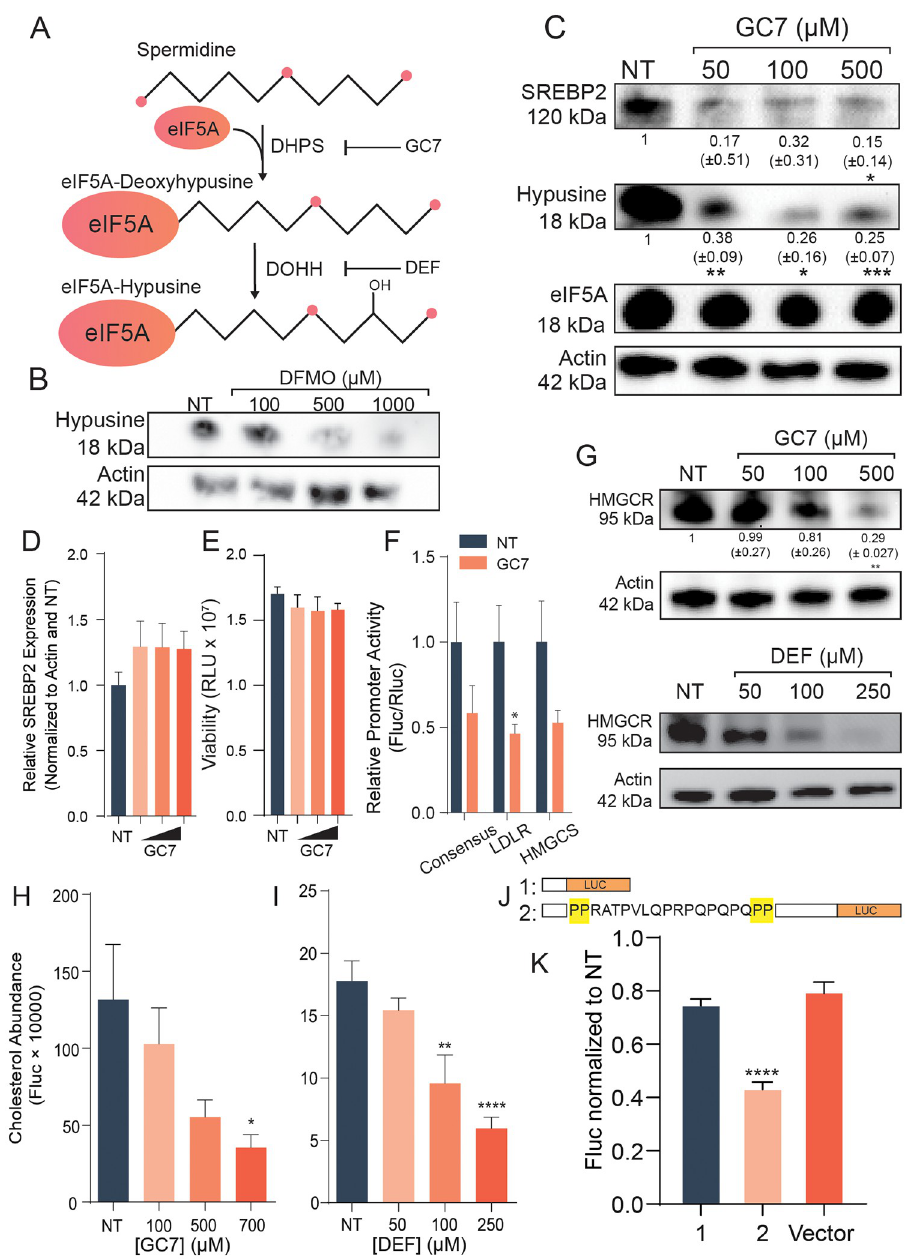
Fig 5. Hypusination supports cholesterol synthesis. (A) Pathway of eIF5A hypusination and its inhibition. (B) Huh7 cells were treated with increasing doses of DFMO and analyzed by western blot for hypusinated eIF5A. (C) Western blot of Huh7 cells treated with increasing doses of GC7 probed for SREBP2, hypusine-eIF5A, and total eIF5A. (D) Huh7 cells were treated with increasing doses of GC7 and SREBP2 transcription measured by qRT-PCR. (E) Cells were treated as in (D) and analyzed for viability after 24h of treatment. (F) Huh7 cells treated with 500 μ M GC7 for 24h followed by transfection with the SRE promoter luciferase constructs and renilla luciferase as a transfection control. Results were normalized to untreated conditions, relative to renilla luciferase activity. Two-way ANOVA was used to analyze statistical significance. (G) Western blot of Huh7 cells treated with increasing doses of GC7 or deferiprone (DEF) and probed for HMGCR. (H, I) Intracellular cholesterol abundance of GC7- and DEF-treated Huh7 cells. (J) Constructs of SREBP2 fused to luciferase used in (K) to measure translation after GC7 treatment. Firefly luciferase activity was measured and normalized to renilla luciferase activity, comparing untreated to GC7 treatment conditions. * p < 0.05, ** p < 0.01, *** p < 0.001, and **** p < 0.0001 by the Student’s t test. Data from at least three independent